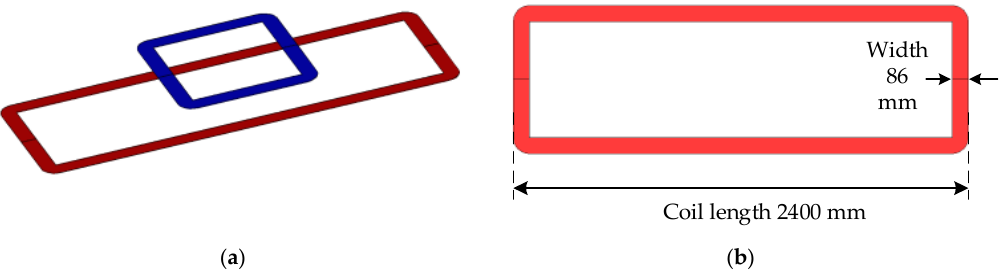
Figure 6. Conventional transmitting coil for dynamic charging. ( a ) Transmitting and receiving coils; ( b ) Transmitting coil.